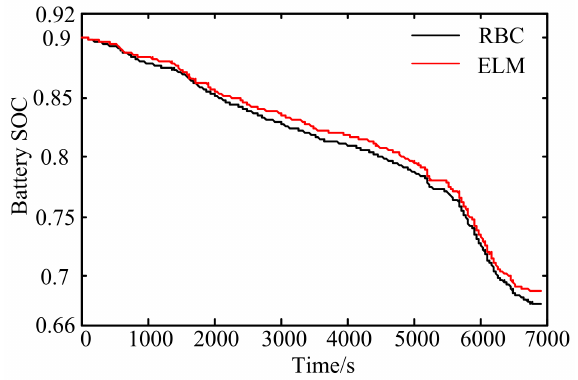
Figure 13. Battery state of charge (SOC). ELM: ELM-based controller.